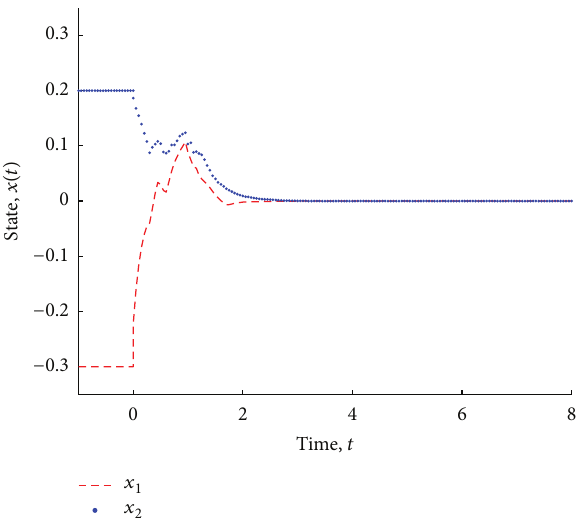
Figure 1: State development of system (8) with parameters